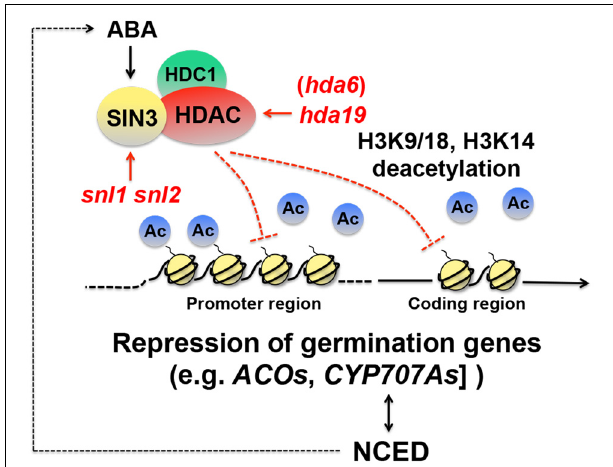
FIGURE 3 | Schematic representation of repression of seed germination genes through histone deacetylation. In yeast, a histone deacetylase (HDAC) interacts with SWI-INDEPENDENT3 (SIN3) (Kadosh and Struhl, 1998; Lai et al., 2001; Grzenda et al., 2009). HDA19, an HDAC ortholog in Arabidopsis, interacts with SIN3-LIKEs (SNLs) (Wang et al., 2013) and HDC1 (Histone Deacetylation Complex1) (Perrella et al., 2013), and removes acetyl groups (Ac) from histone 3 lysine9/18 (H3K9/18) and lysine14 (H3K14) and represses genes positively affecting germination, such as 1-AMINOCYCLOPROPANE-1-CARBOXYLATE OXIDASEs ( ACOs ) and CYP707As , ABA deactivation genes (Wang et al., 2013). Deacetylation occurs in both the promoter and coding regions. Both snl and hda19 mutations cause reduced dormancy (Wang et al., 2013). Expression of NCED4 , an ABA biosynthesis gene, is reduced in the snl1 snl 2 double mutant, suggesting that the SNL-HDA19 complex imposes seed dormancy also through the promotion of ABA biosynthesis. SNL expression is promoted by ABA (Wang et al., 2013), which suggests that there is a positive feedback loop to maintain high ABA levels through the SNL-HDA19